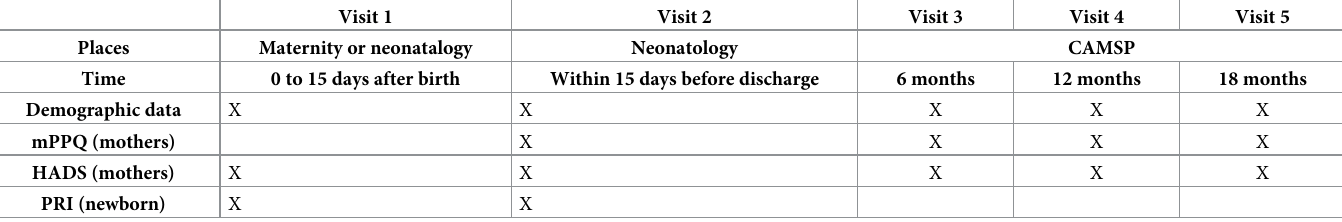
Table 1. Study design: 5 assessment